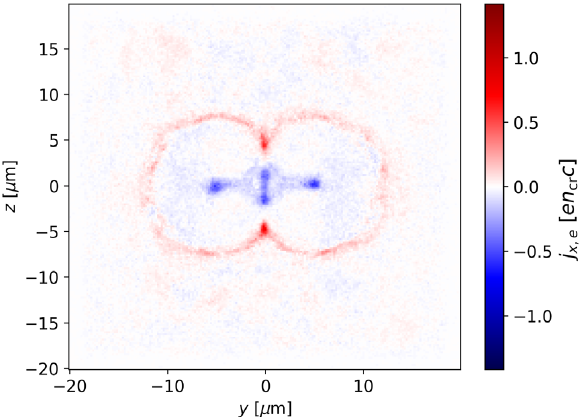
FIG. 1. Longitudinal currents induced by the electrons in a y - z - slice of the plasma target when the two channels are formed by the laser pulses at t ¼ 427 fs. At the center of each channel and in the region between the two pulses, a current (blue) is flowing, which is compensated by a return current at the channel walls (red).